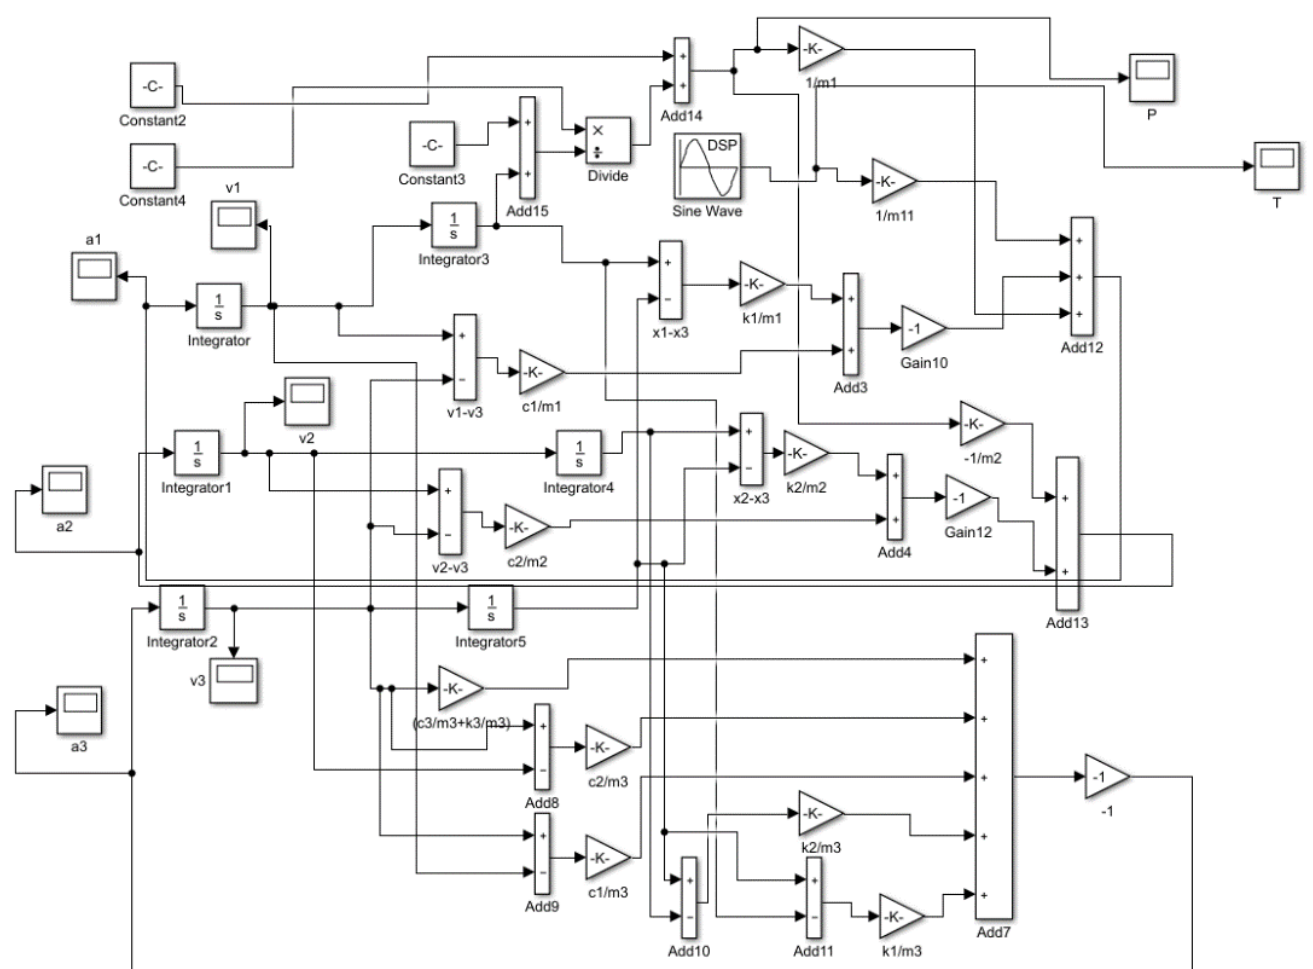
Figure 3. The dynamics Simulink model of a T630 COF machine. Based on the oscilloscope results in the dynamics Simulink model, vertical accelera- tions of the swing shaft, the lower die and the frame are obtained in Figure 4. The ampli- tudes of these accelerations are 1.97 m/s 2 , 0.82 m/s 2 and 0.12 m/s 2 , respectively. The swing shaft contacts the product directly, and the vibration on the swing shaft is fierce, which is detrimental to the quality of the product. The vibration controls of the COF machine are proposed in the later section.